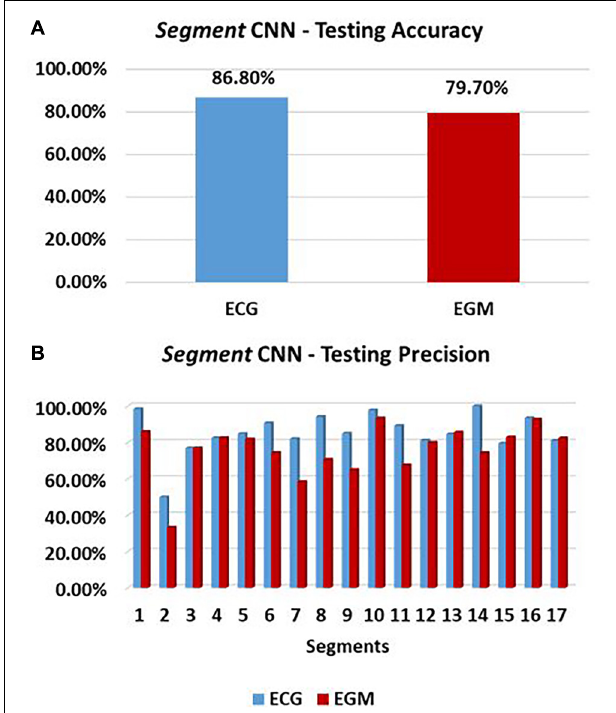
FIGURE 9 | Cartesian probability-based CNN performance. Testing performance of 17-feature Segment CNN is here reported in terms of accuracy (%) (A) , and precision (B) for each of the 17 segments of the LV mesh. ECG-based and EGM-based testing performances are reported in blue and red,